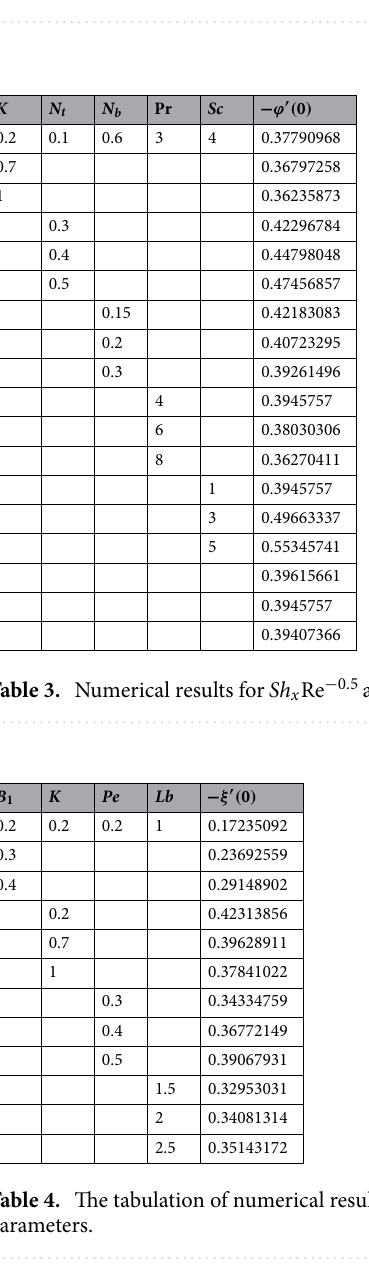
Table 2. The tabulation of numerical results for Drag force C F Re parameters.